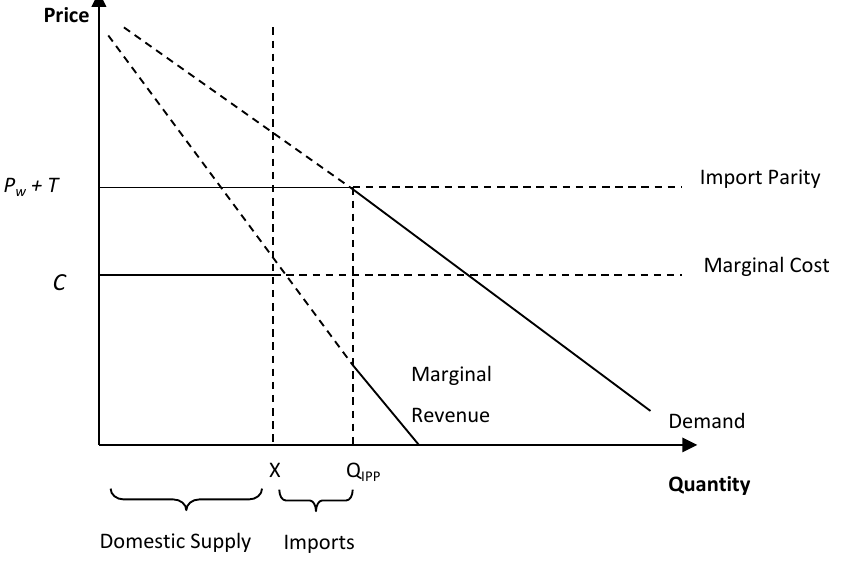
FIGURE 3: IPP with excess demand and domestic monopoly Source: Derived from economic first